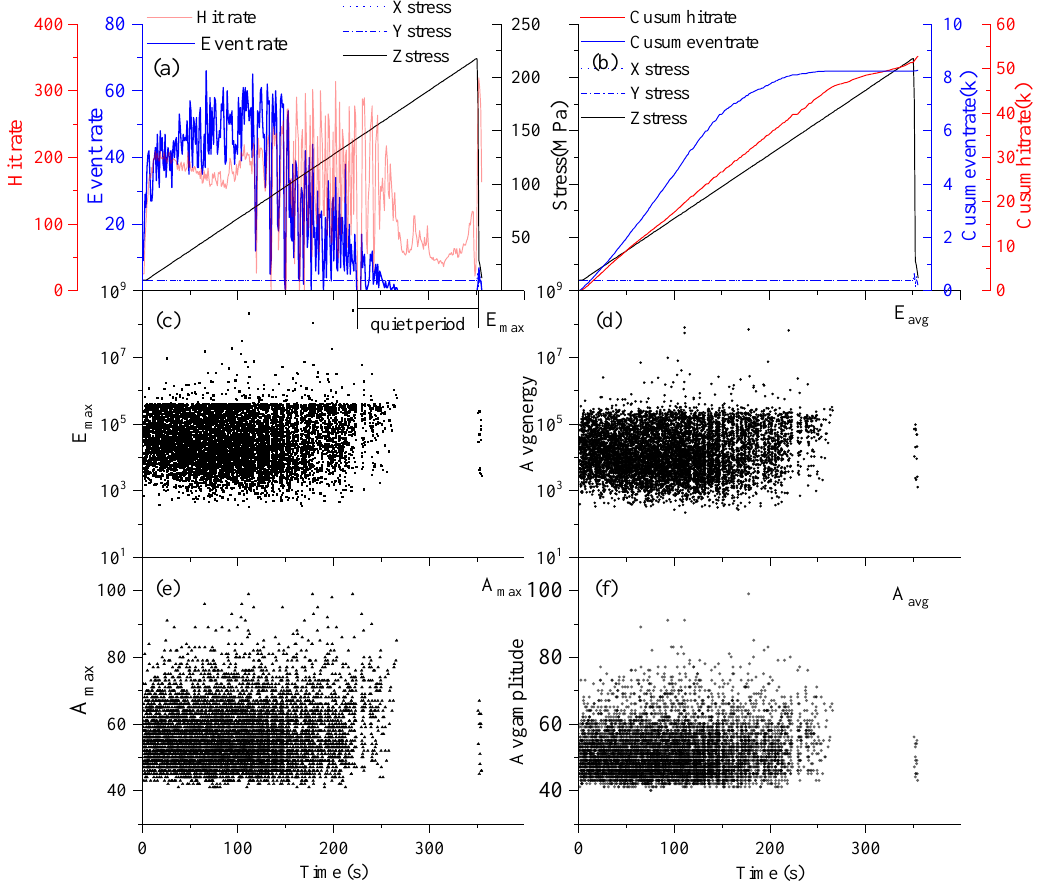
Figure 3. AE parameters of G-10-10: ( a ) HR, ER, and stress vs. loading time; ( b ) CHR, CER, and stress vs. loading time; ( c ) E max of AE events; ( d ) E avg of AE events; ( e ) A max of AE events; and ( f ) A avg of AE events. AE